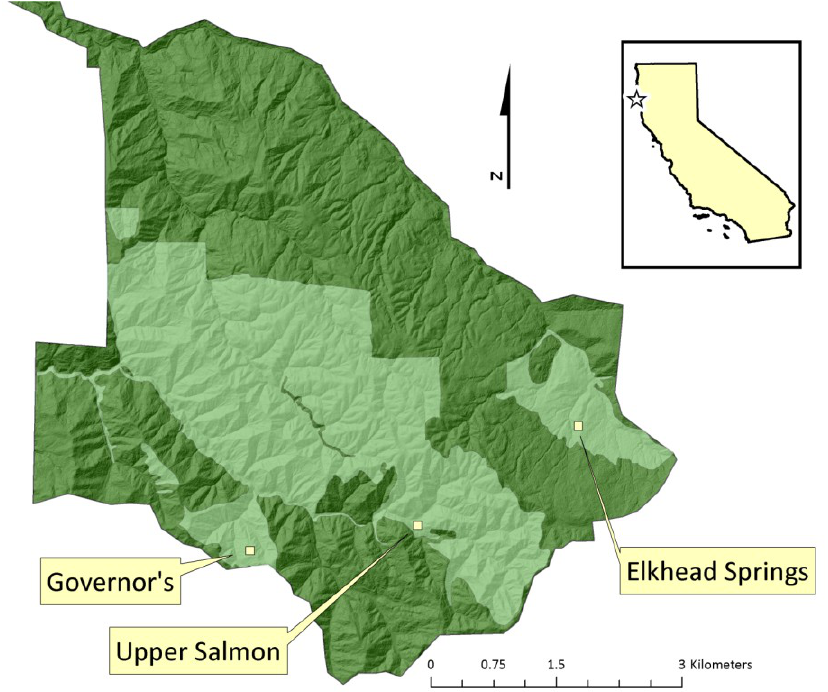
Figure 1. Headwaters Forest Reserve location map with hillshade depicting topography within the 3025-ha property, and locations of three 1-ha plots describing reference conditions within remnant old-growth stands (shown in lighter shade). Inset shows location in California,